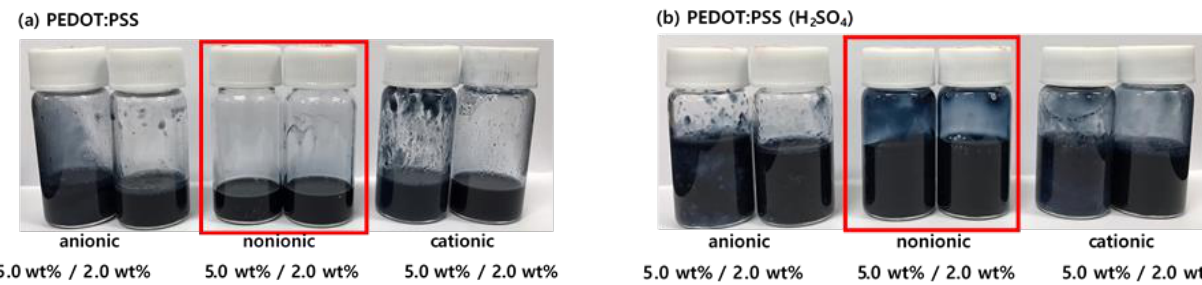
Figure 2. ( a ) Compatibility of PEDOT:PSS and ( b ) sulfuric acid-doped PEDOT:PSS with different types of WPU.